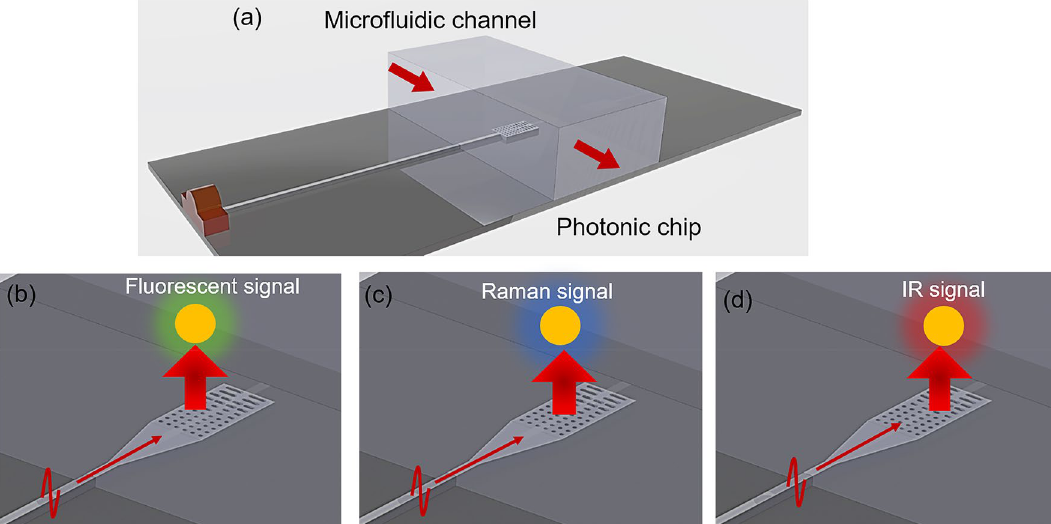
Figure 1. Opto-fluidic Lab on the chip sensing system. ( a ) Photonic waveguide technology integrated with a microfluidic chip to perform high throughput detection and sensing. ( b ) Planar photonic waveguide based light excitation and detection for fluorescence spectroscopy. The excitation of the sample (shown in red) generates a fluorescent signal (shown in green) detected by adjoining detectors ( c ) Planar waveguide-based light excitation for on-chip Raman spectroscopy. The Raman signals are represented in blue. ( d ) Planar waveguide-based light excitation for on-chip IR spectroscopy where excitation and detection signals are shown in red. Figure created in Solidworks